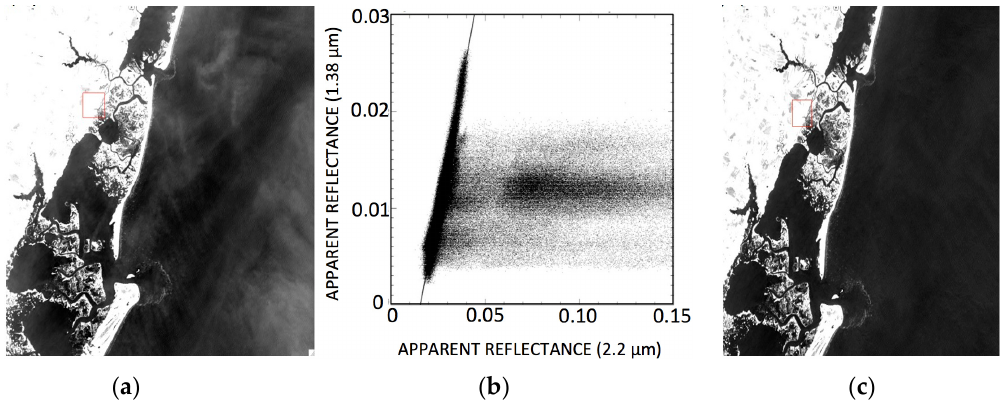
Figure 8. ( a ) A Landsat 8 OLI SWIR2 band image acquired over Delaware in the eastern United States on 17 April 2014; ( b ) The scatter plot of Band 9 (cirrus) versus SWIR2 band; ( c ) The cirrus-corrected SWIR2 image.